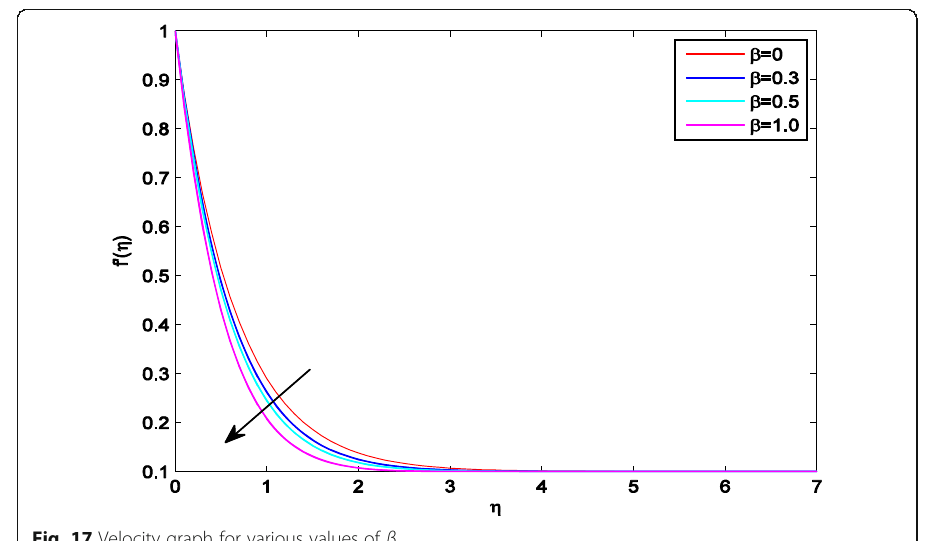
Fig. 17 Velocity graph for various values of β